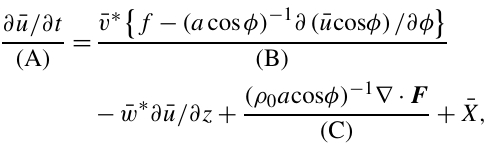
Figure 1. (a) Latitude–time cross section of the 15-day running mean of the climatological zonal-mean zonal wind at 50hPa ( ¯ U 50; lines and color shading) from 1 October through 31 March. The contour interval is 2.0ms − 1 . (b) Time series of the climatological 15-day running mean of the PNJ index (ms − 1 , blue), defined as zonal-mean zonal wind speed at 60–80 ◦ N and 50hPa. Dark gray shading indicates the 20th to 80th percentiles, medium gray shad- ing indicates the 10th to 90th percentiles, and light gray shading indicates the 5th to 95th percentiles. The two gray dashed lines in- dicated the daily minimum and maximum of the PNJ. The blue dot- ted (dashed) line indicates the daily median (mode) of the PNJ. The vertical black dotted lines indicate the period of the short break in late